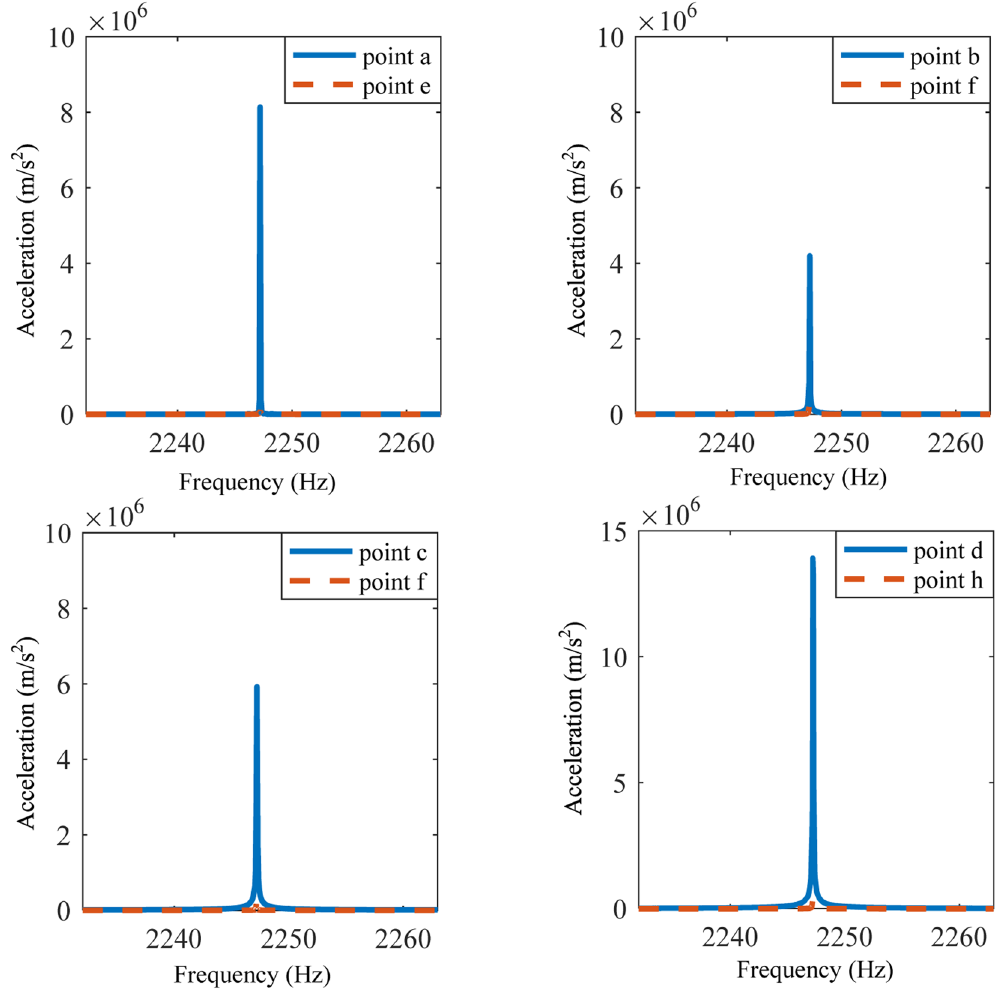
Figure 6. Responses of points a-h at frequency at 2247Hz when the elastic wave metamaterial plate is not attached by the active control